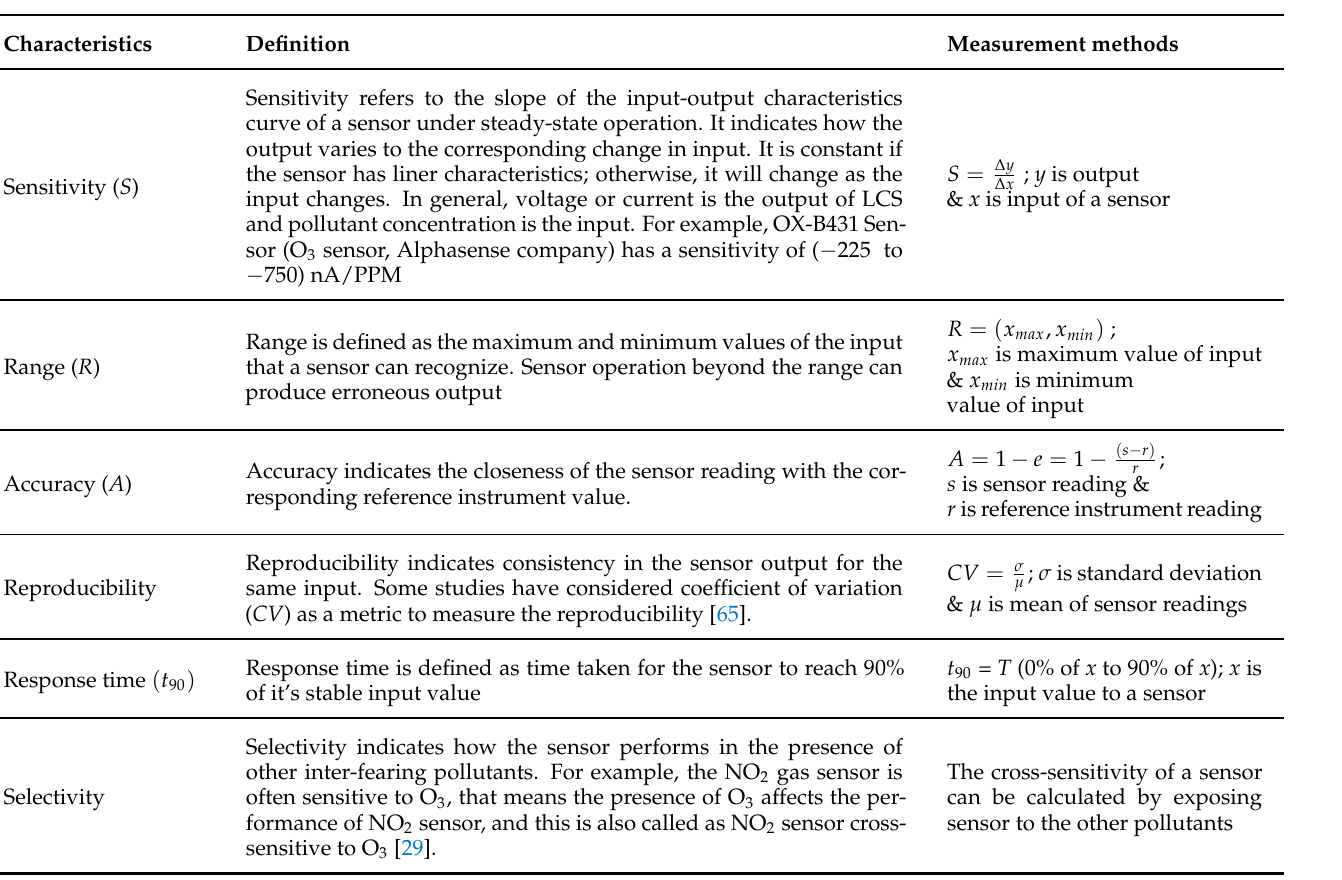
Table 3. Various characteristics of